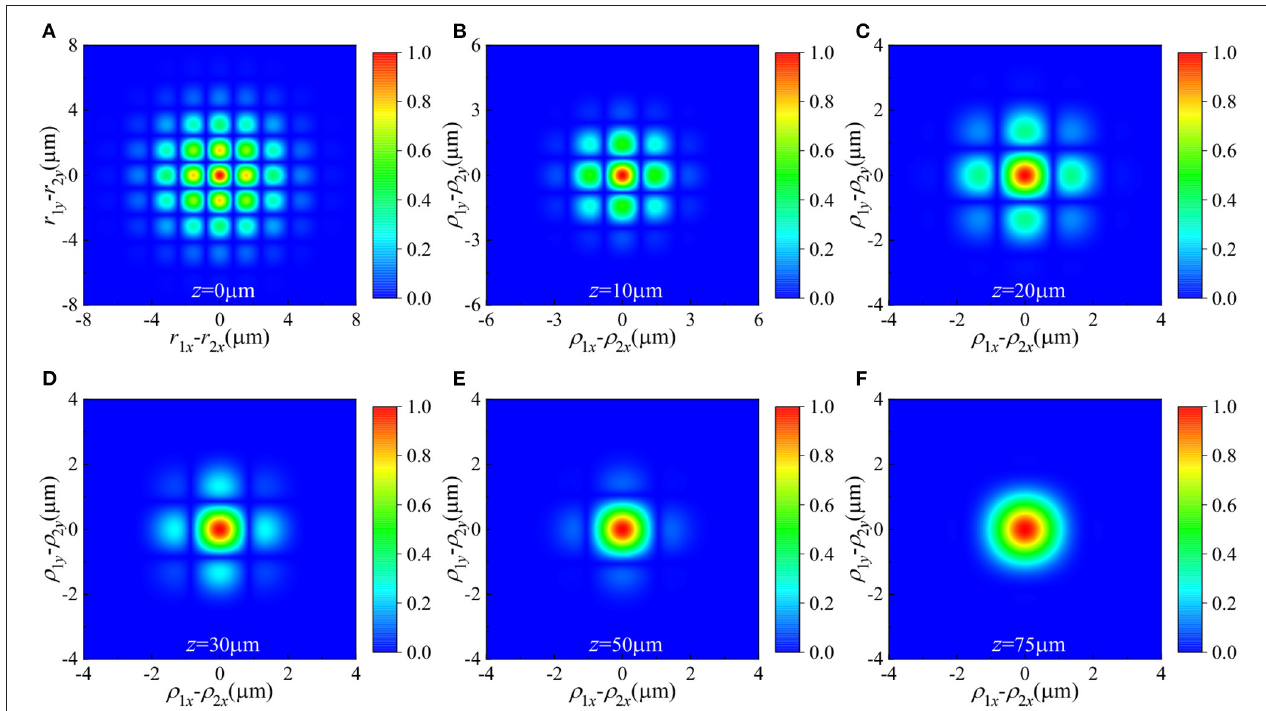
n 0 propagating through a turbulent biological tissue at different = =